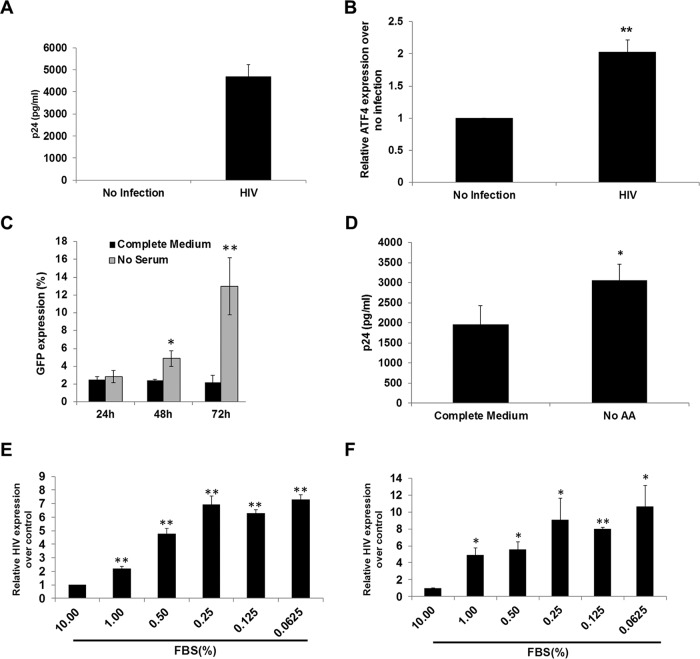
Nutrient deprivation in human CD4+ T cells induces ATF4 expression and HIV LTR activation. (A and B) Isolated primary CD4+ T cells from healthy HIV-negative donors (n = 4) were infected with HIV for 5 days, HIV p24 levels in supernatants were measured by ELISA (A), and cell-associated ATF4 RNA levels were determined by RT-qPCR (B). (C) To determine the effect of nutrient deprivation, J-Lat A1 cells were cultured in medium without serum for 24 to 72 h, and HIV LTR-driven GFP expression was assessed by flow cytometry. (D) Primary human CD4+ T cells were infected with HIV in complete medium or in medium without amino acids, and HIV p24 expression was determined by ELISA. (E) J-Lat A1 cells were cultured in low levels of serum (10% to 0.0625% of serum in medium) for 48 h, and HIV LTR-driven GFP expression was measured by RT-qPCR. (F) The U1 cells were cultured in low levels of serum (10% to 0.0625% of serum in medium) for 48 h. HIV RNA was measured using RT-qPCR. *, P < 0.05; **, P < 0.01. Experiments were performed a minimum of three times.